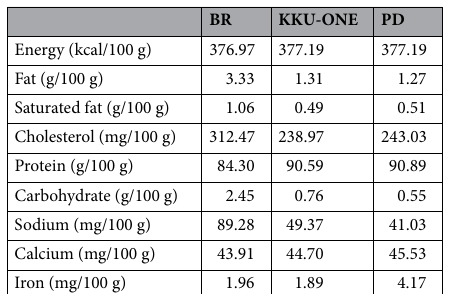
Table 3. The nutritive values of breast meat from different chicken breeds. BR: Commercial broiler, KKU- ONE: Commercial broiler × Thai native crossbred, PD: Thai native chicken (Pradu Hang Dam).